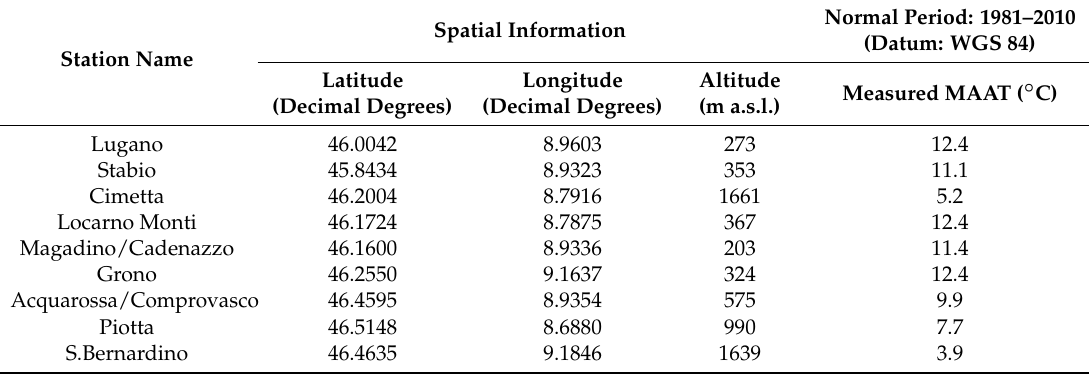
Table 2. Information regarding Cantone Ticino’s MeteoSwiss stations used for Mean Annual Air Temperature (MAAT) map